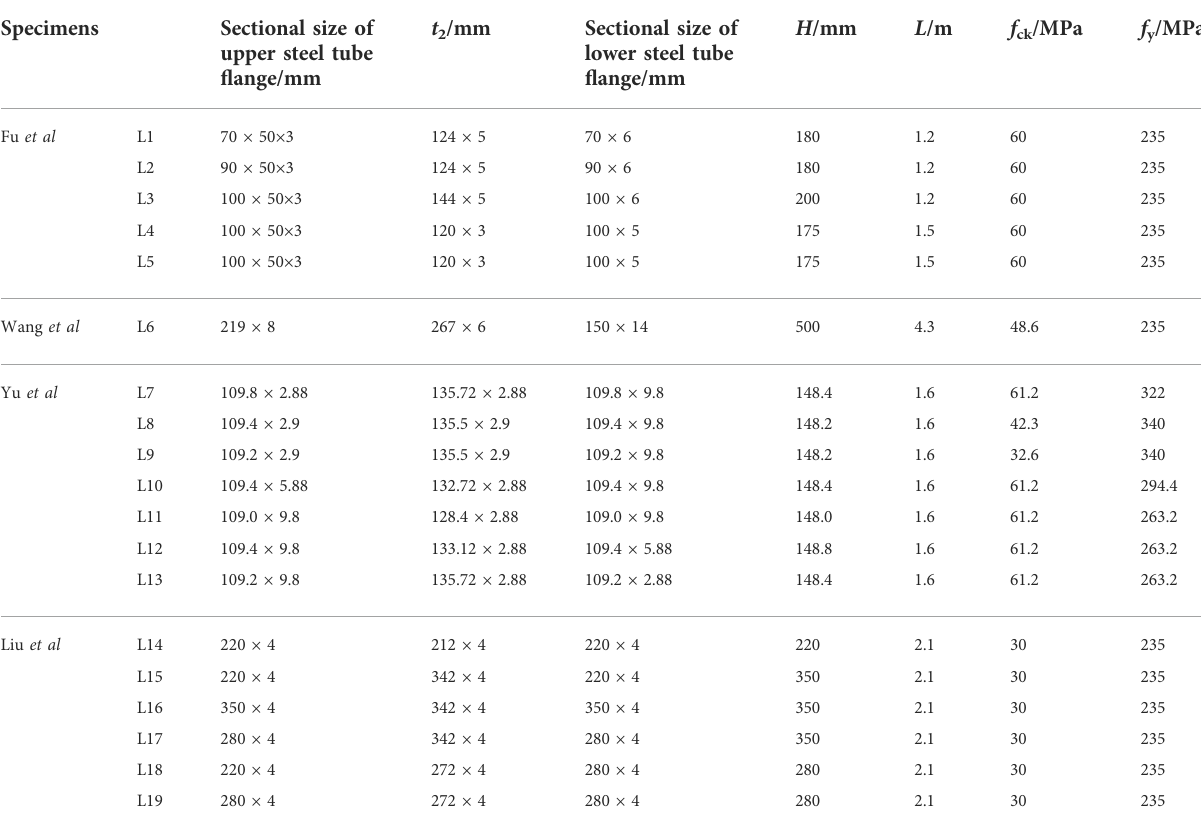
TABLE 3 The speci fi c parameters of 19 existing